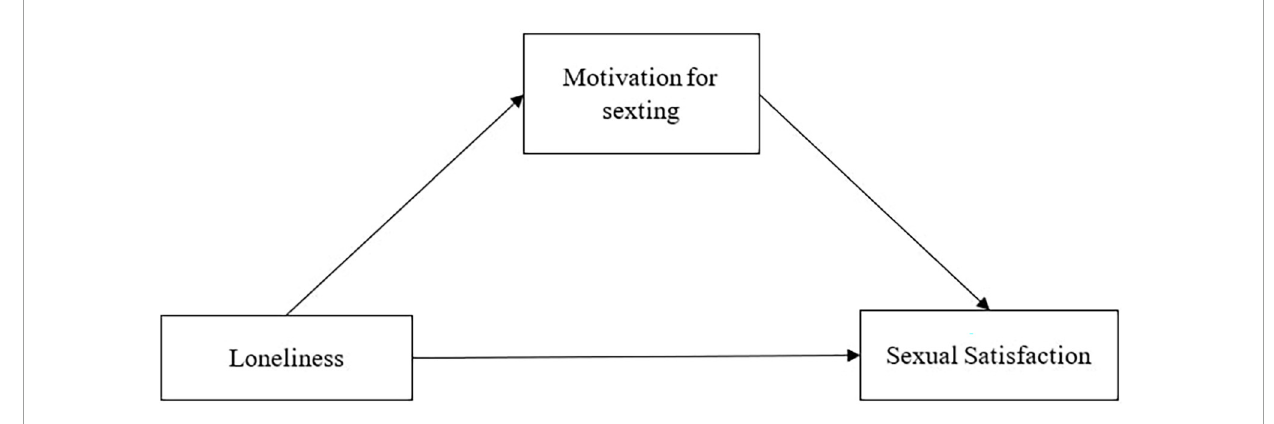
FIGURE1 The hypothesized research